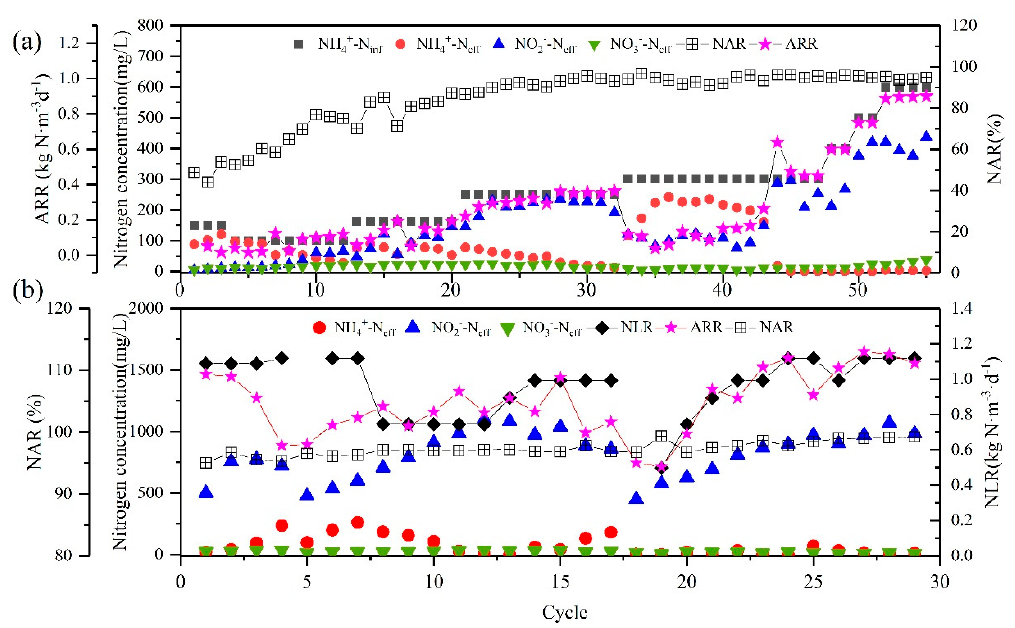
Figure 2. Operational performance of nitritation by a zeolite sequencing batch reactor during phase I and II for liquid-ammonia mercerization wastewater: ( a ) ammonia removal in the zeolite sequencing batch reactor during phase I; ( b ) ammonia removal in the zeolite sequencing batch reactor during phase